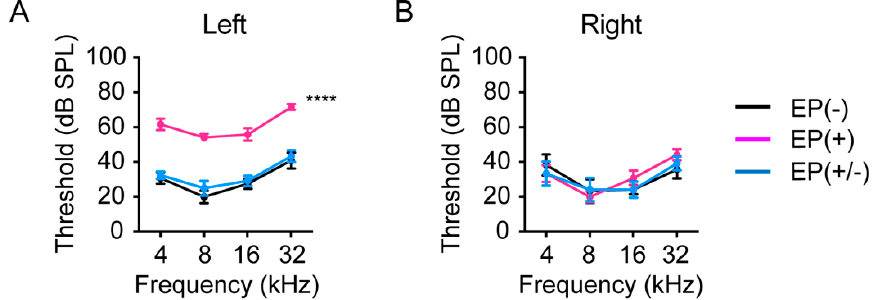
Figure 2. Effects of earplugs on hearing thresholds. ( A ) ABR thresholds in the EP(+) mice were significantly different from those in the EP(-) and EP(+/-) mice in the occluded left ear. ABR thresholds were measured at 12 weeks of age in the EP(-) and EP(+) mice, and at 4 weeks after EP removal in the EP(+/-) mice (n = 5 per group). ( B ) No significant differences were observed in the ABR thresholds of the right ear among the groups. ABR measurements were examined at 12 weeks of age in the EP(-) and EP(+) groups and at 16 weeks of age in the EP(+/-) group ( n = 5 per group). EP, earplug; ABR, auditory brainstem response; SPL, sound pressure level. **** p < 0.0001.